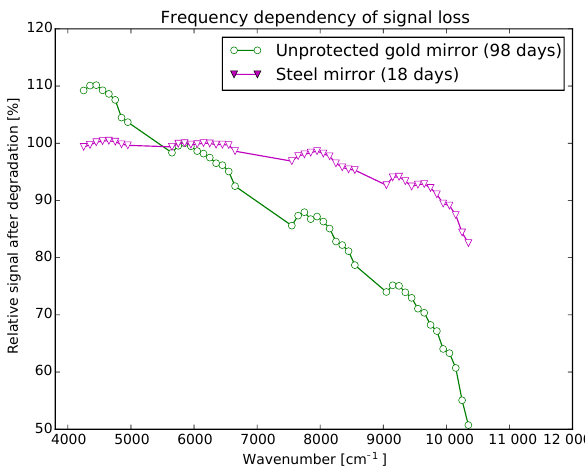
Figure 12. Effect of mirror degradation on frequency response at the reference points defined in Fig. 11. The green circles were de- rived from S 3 / S 1 and the magenta triangles from S 5 / S 4 (from Ta- ble 3).